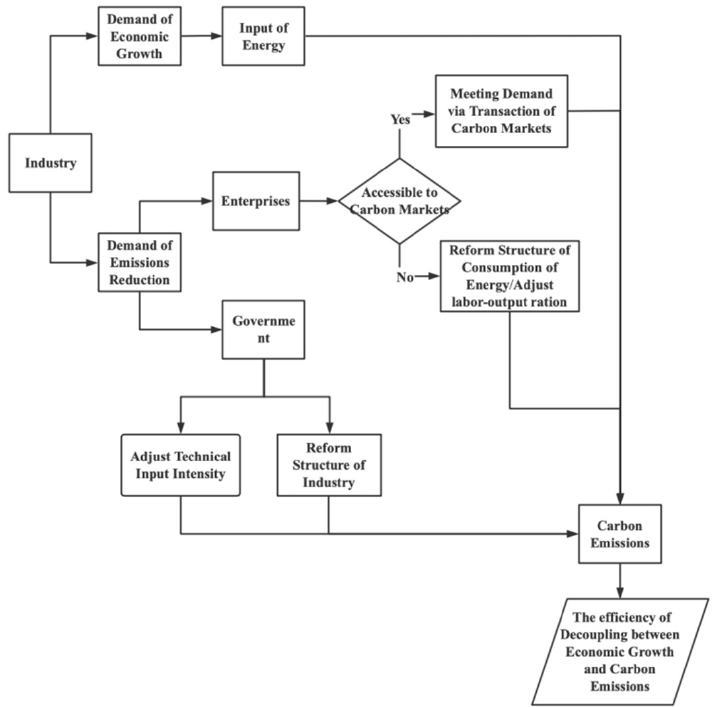
Figure 1. Transmission mechanism of industrial economy and carbon decoupling.